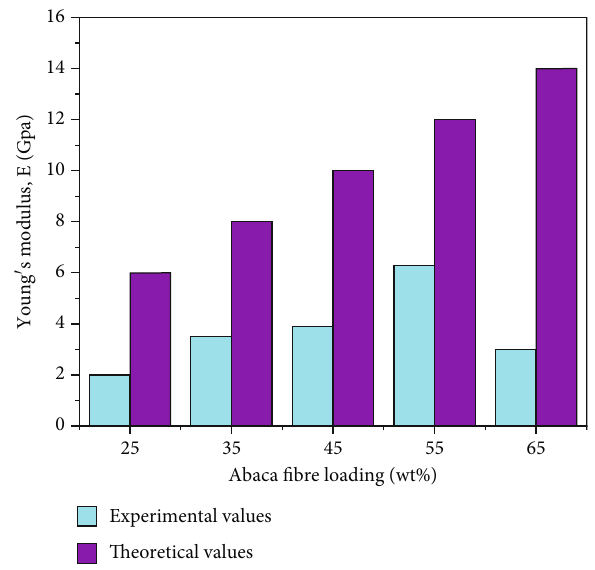
Figure 4: Tensile strength (MPa) vs abaca fi bre loading comparison between experimental and theoretical results (wt percent).